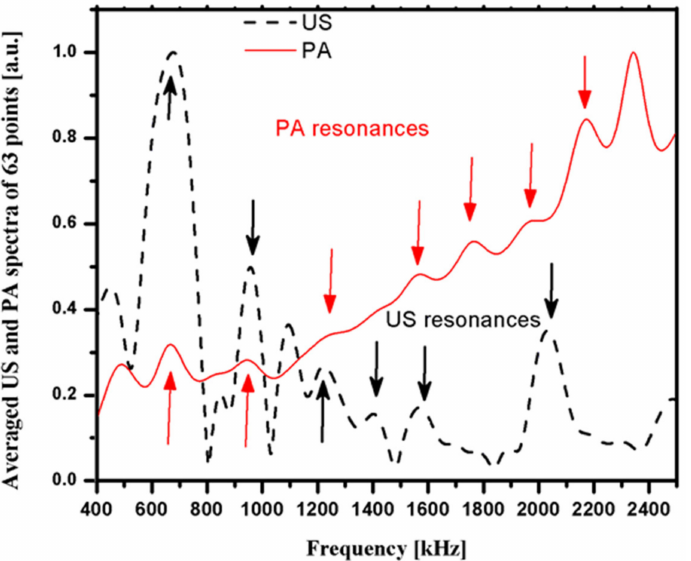
Figure 6. Normalized spectra for US and PA signals vs. source frequency with 63 measurement